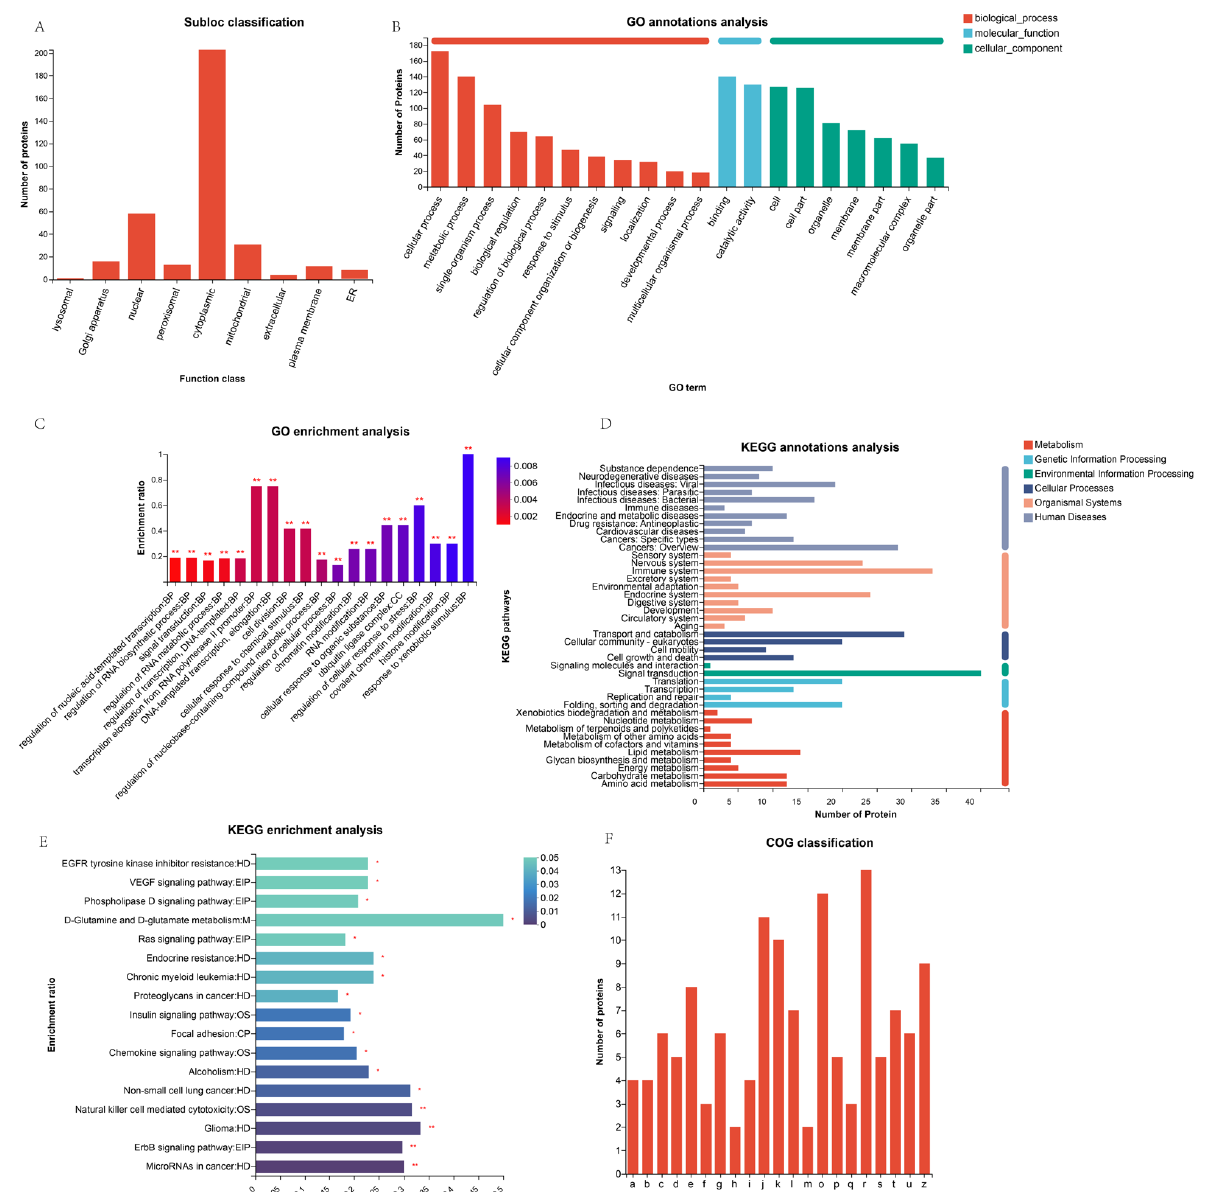
Figure 2. Bioinformatics analysis of DEPs from CCO cells with or without SHVV cultured in the complete medium. (A) Subcellular localization of DEPs. (B) GO annotations analysis of DEPs. (C) GO enrichment analysis of DEPs. (D) KEGG annotations analysis of DEPs. (E) KEGG enrichment analysis of DEPs. (F) COG analysis of DEPs. (a) RNA processing and modification; (b) Chromatin structure and dynamics; (c) Energy production and conversion; (d) Cell cycle control, cell division, chromosome partitioning; (e) Amino acid transport and metabolism; (f) Nucleotide transport and metabolism; (g) Carbohydrate transport and metabolism; (h) Coenzyme transport and metabolism; (i) Lipid transport and metabolism; (j) Translation, ribosomal structure and biogenesis; (k) Tran- scription; (l) Replication, recombination and repair; (m) Cell wall/membrane/envelope biogenesis; (o) Posttranslational modification, protein turnover, chaperones; (p) Inorganic ion transport and metabolism; (q) Secondary metabolites biosynthesis, transport and catabolism; (r) General func- tion prediction only; (s) Function unknown; (t) Signal transduction mechanisms; (u) Intracellular trafficking, secretion, and vesicular transport; (z) Cytoskeleton. *, p -value < 0.05; **, p -value <